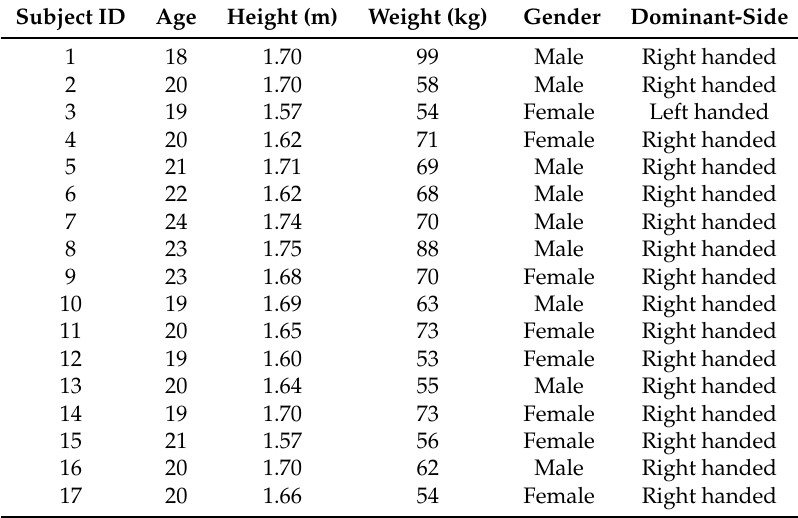
Table 4. Statistics of the